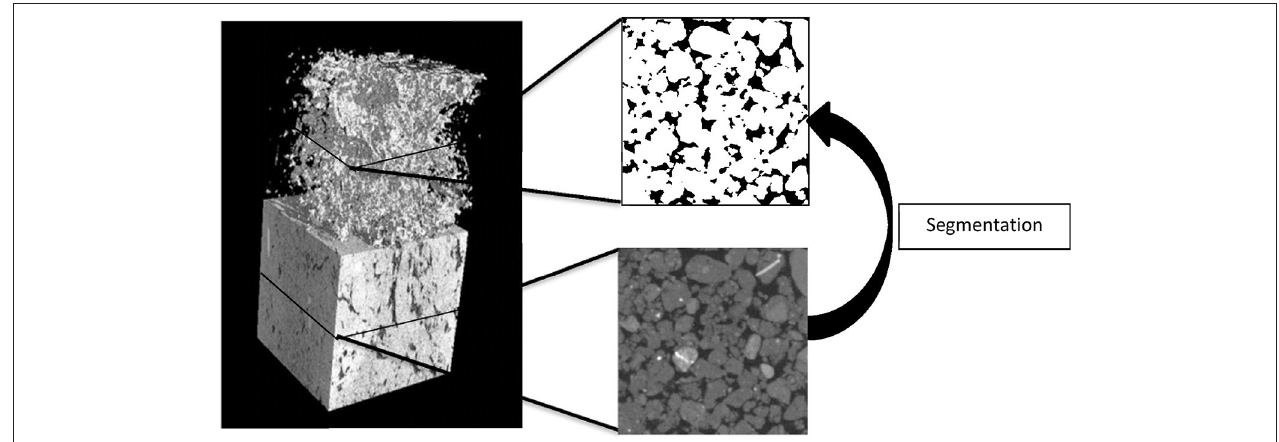
FIGURE 1 | An example of a section of an X-ray CT scan of a repacked sieved soil sample (left) showing the solid and pore volumes and the 3D pore volume). An example of a transect is shown with the solid phase (gray) and pores (black). The pore volume is identified through segmentation which produces a binary image with pores (black) and the solid phase (white).